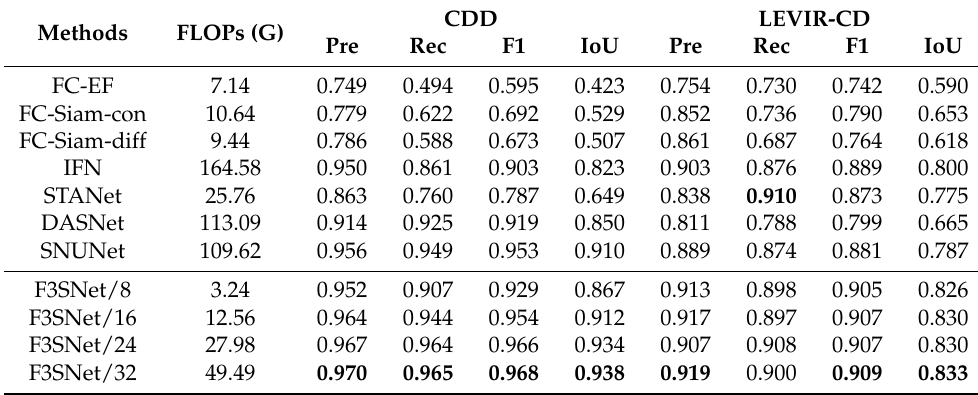
Table 1. Comparison results on the two CD test sets. The highest scores are marked in bold. The size of the input image for the model is 256 × 256 × 3 to calculate GFLOPs.